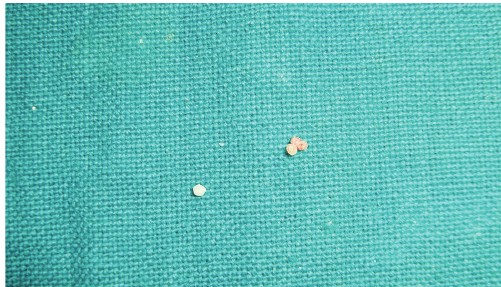
Figure 4: OPG revealing pulp stones in all second deciduous molars, first permanent molars, and mandibular central Figure 2: Pulp Stones.